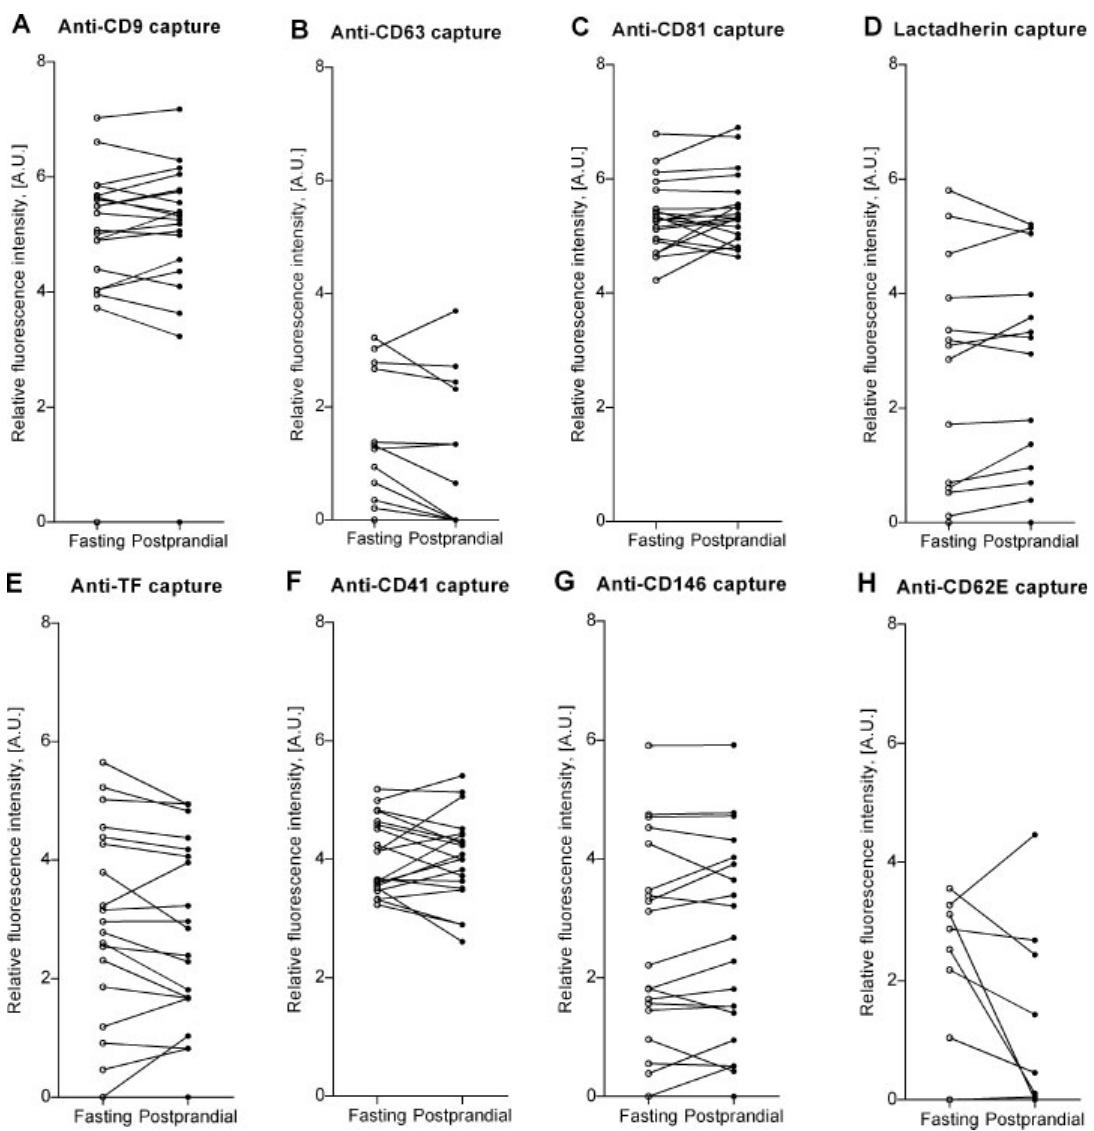
Fig. 4 Fasting and postprandial content of small extracellular vesicles (EVs) in general (( A ) anti-CD9, ( B ) anti-CD63, and ( C ) anti-CD81 antibody capture), ( D ) phosphatidylserine-positive (PS þ ) small EVs (lactadherin capture), and small EV subtypes exposing speci fi c antigens (( E ) anti – tissue factor (TF), ( F ) anti-CD41, ( G ) anti-CD146, and ( H ) anti-CD62E antibody capture) as semi-quanti fi ed by use of EV Array with an “ exosome cocktail ” consisting of fl uorescently labeled antibodies against CD9, CD63, and CD81 as detecting agents. Lines combine fasting levels ( open circles ) with postprandial levels ( closed circles ) for each study participant. A.U., arbitrary